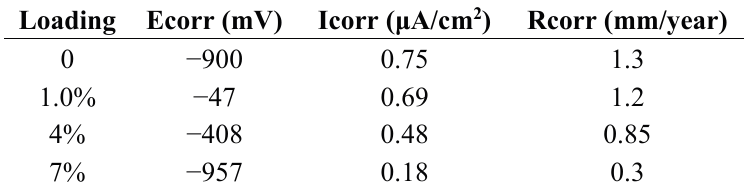
Figure 6. The Tafel plots for GNS-based epoxy resin coating with various content of (A) 0; (B) 0.1 wt %; (C) 0.4 wt %; and (D) 0.7 wt %. Table 2. Anticorrosive performance of GNS-based epoxy resin coating as measured from electrochemical corrosion